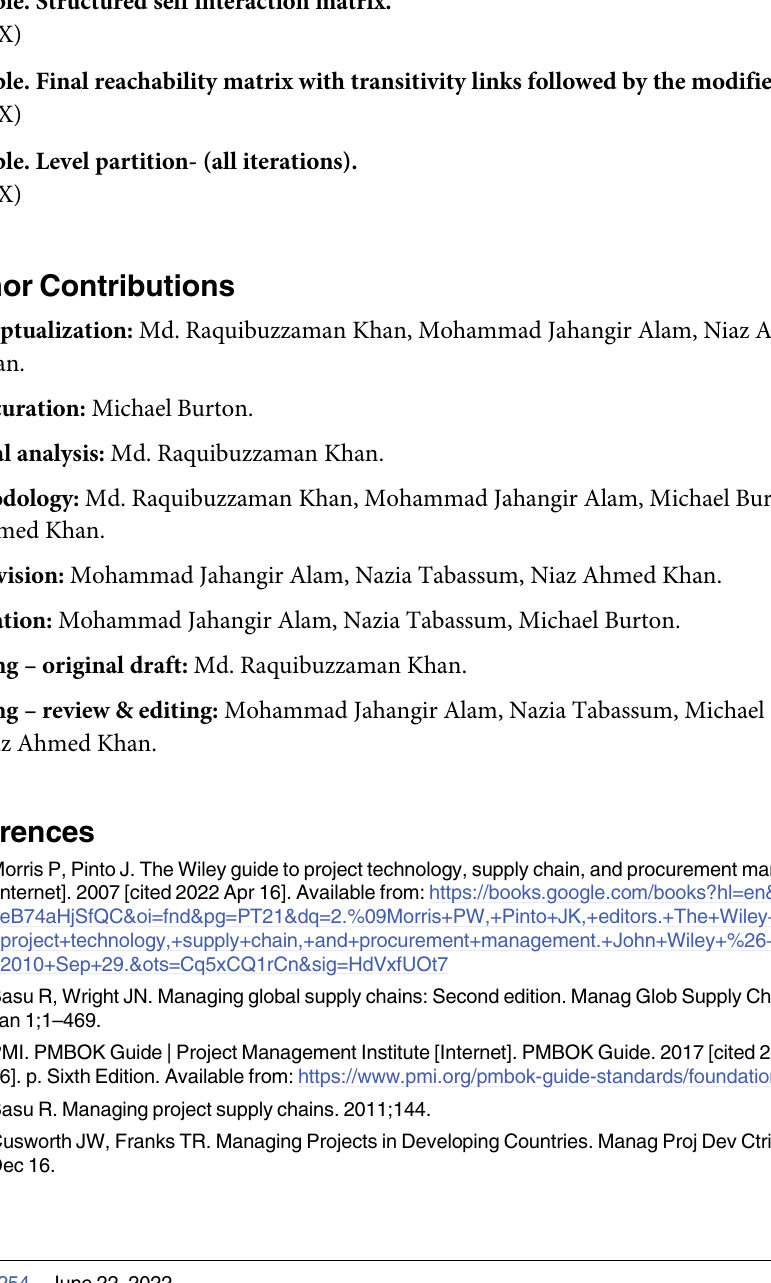
S1 Table. Respondents participated in the modified Delphi round. S2 Table. Respondents participated in the BWM interview. S3 Table. Respondents participated in the ISM brainstorming session. S4 Table. Average weights of the SCCs of GoB funded projects obtained from BWM, and weights during sensitivity analysis. S5 Table. Structured self interaction matrix. (DOCX) S6 Table. Final reachability matrix with transitivity links followed by the modified process. S7 Table. Level partition- (all